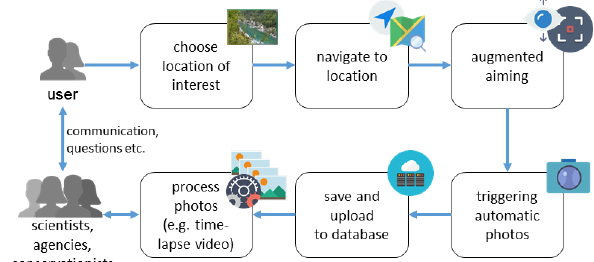
Figure 1. Workflow of the PAN project.